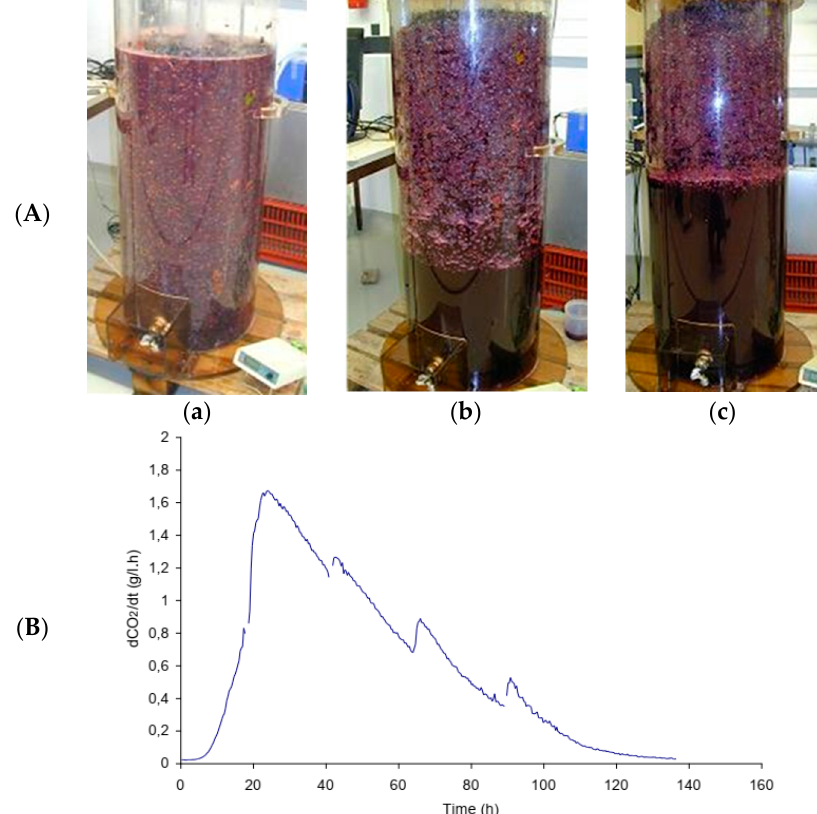
Figure 7. ( A ) Cap formation during red wine fermentation. ( a ) Tank filling, ( b ) after fermentation of 5% of the sugar, ( c ) after fermentation of 40% of the sugar. ( B ) Effect of cap punching on fermentation kinetics. Increase in CO 2 production rates after cap punching owing to a transfer of yeasts from the cap to the liquid phase, increasing the size of the cell population in the liquid.